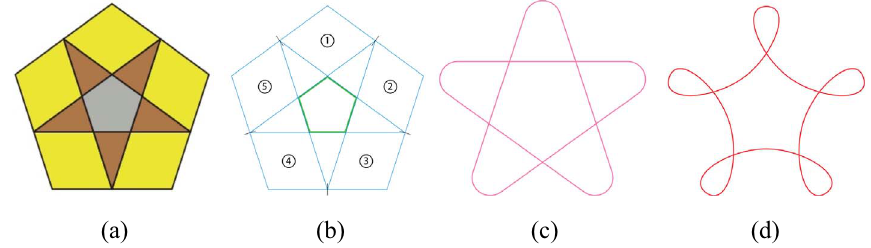
Figure 23. (a) Cross section of GML n for SS 1 ; 3 cut, case BII, (b) generation of graphs for case BII, (c) 5/2 knot, (d) graph with loops 5 corresponding to sectors 1 – 5 in Figure